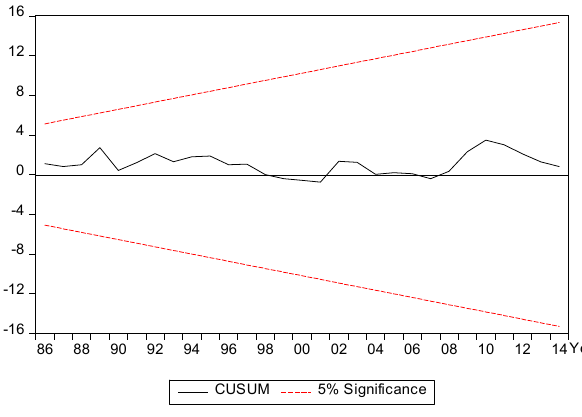
Figure 3. Stability test using (CUSUM).